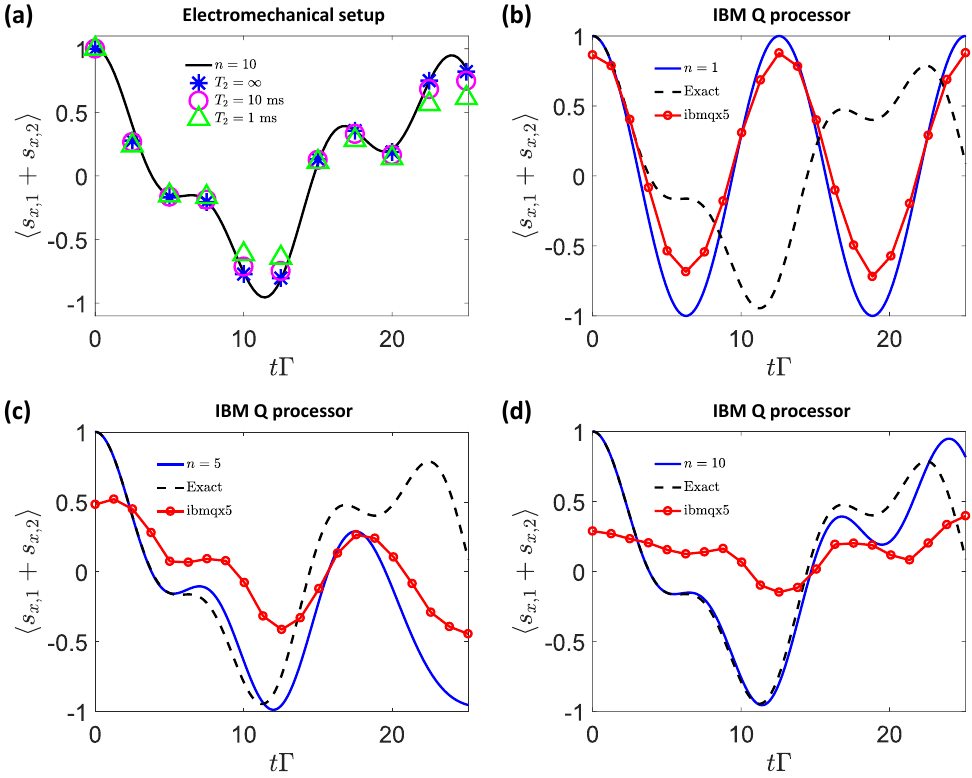
Figure 2. Digital quantum simulation of the TIM. ( a ) Numerical results obtained for the proposed electromechanical set-up, for different values of the NRs T 2 and n = 10 Suzuki-Trotter iterations, compared to the corresponding ideal results (for the same digital decomposition in n = 10 steps). ( b – d ) Experimental data from the IBM Q ibmqx5-Rueschlikon real backend, for increasing values of the number of Suzuki-Trotter iterations. The dashed line represents the exact result with no digital